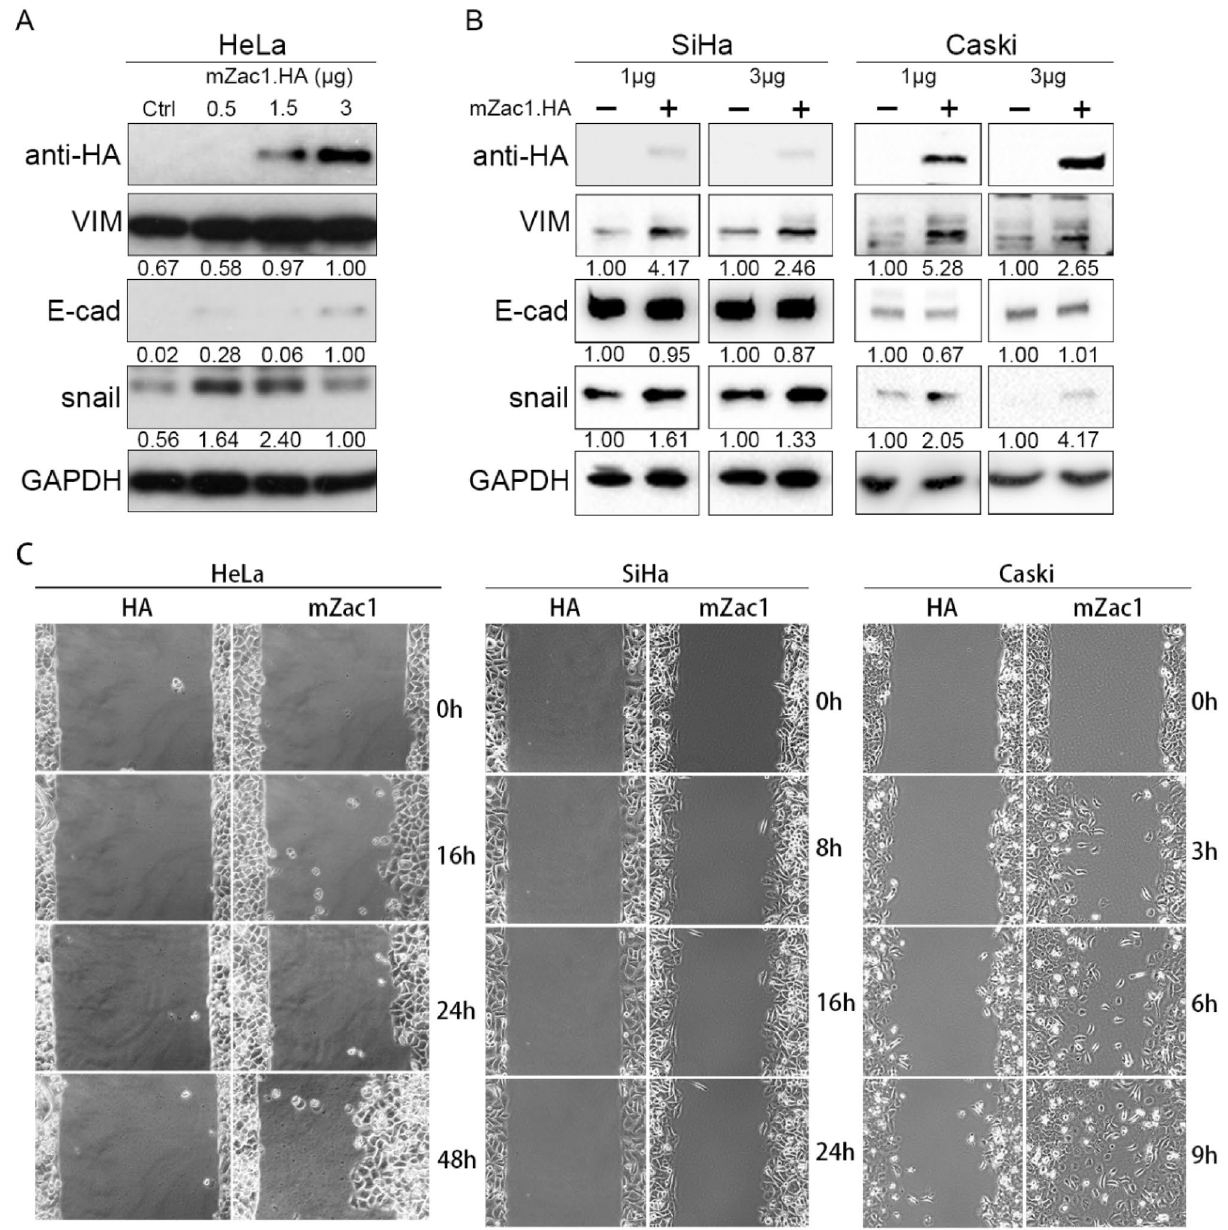
Figure 7. Overexpression of mZac1 amplified mesenchymal marker expression and migration in several cervical cancer cells. Western blot analysis of HA (mZac1.HA, 110 kDa), vimentin (VIM, 57 kDa), E-cadherin (E-cad, 135 kDa), and snail (29 kDa) expression in (A) HeLa cells with 0.5, 1.5, and 3 μg mZac1.HA/empty HA vector transfection and (B) SiHa and Caski cells with 1 and 3 μg mZac1.HA ( +) or empty HA vector (−) transfection. Relative band intensity was identified by ImageJ (Fiji). (C) Wound healing assay. HeLa, SiHa, and Caski cells were transfected with HA vector and HA.mZac1 respectively. Movement of cells into wound area was shown for HA vector and HA.mZac1-transfected cells at different time points post scratch (×